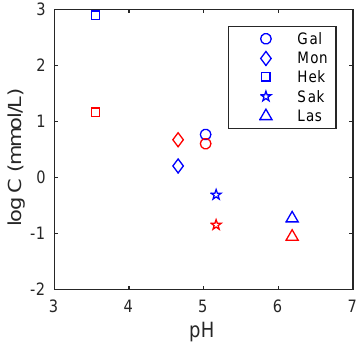
Figure 8. Concentrations of iron (blue) and halogens (Cl + F in red) released form ash samples during the leaching experiment of Jones and Gislason (2008) as function of